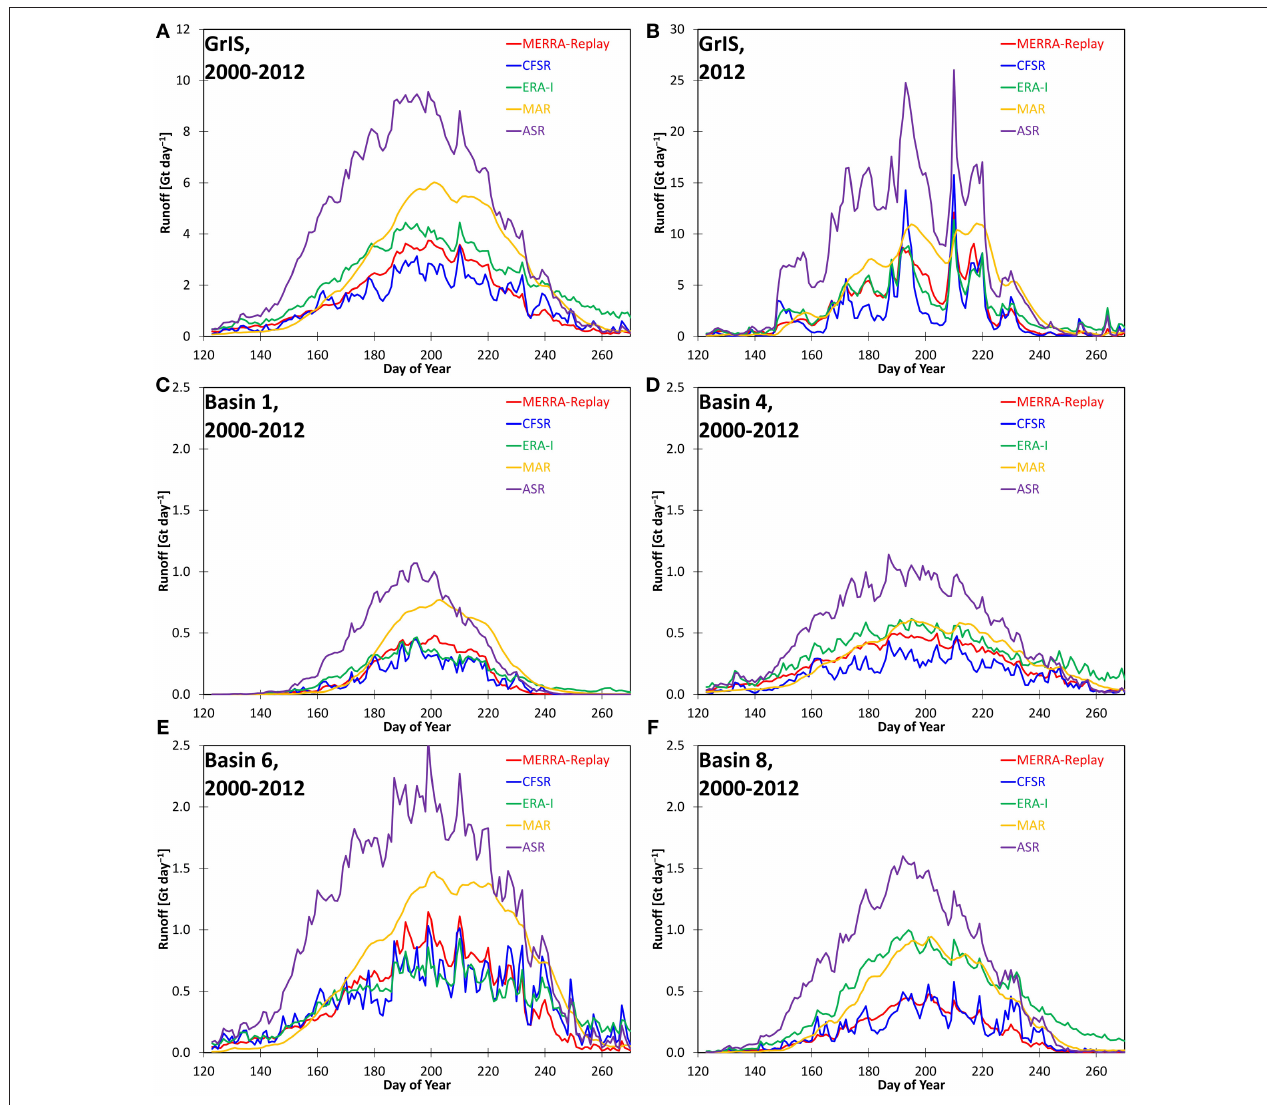
FIGURE 9 | Annual time series of runoff from five data sets for (A) the total GrIS, averaged for 2000-2012; (B) the total GrIS for the year 2012; and (C) drainage basin 1, (D) basin 4, (E) basin 6, and (F) basin 8 averaged for 2000-2012, in Gt day − 1 .